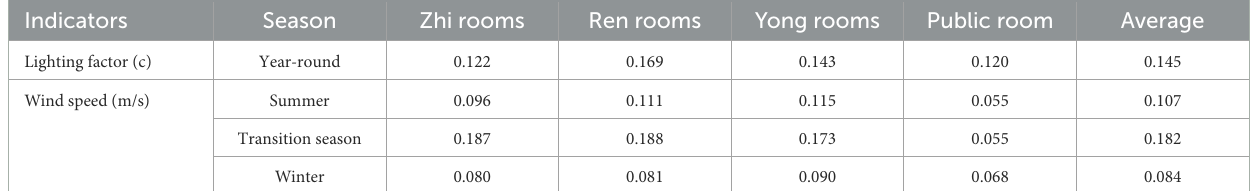
TABLE 2 Statistics of lighting and